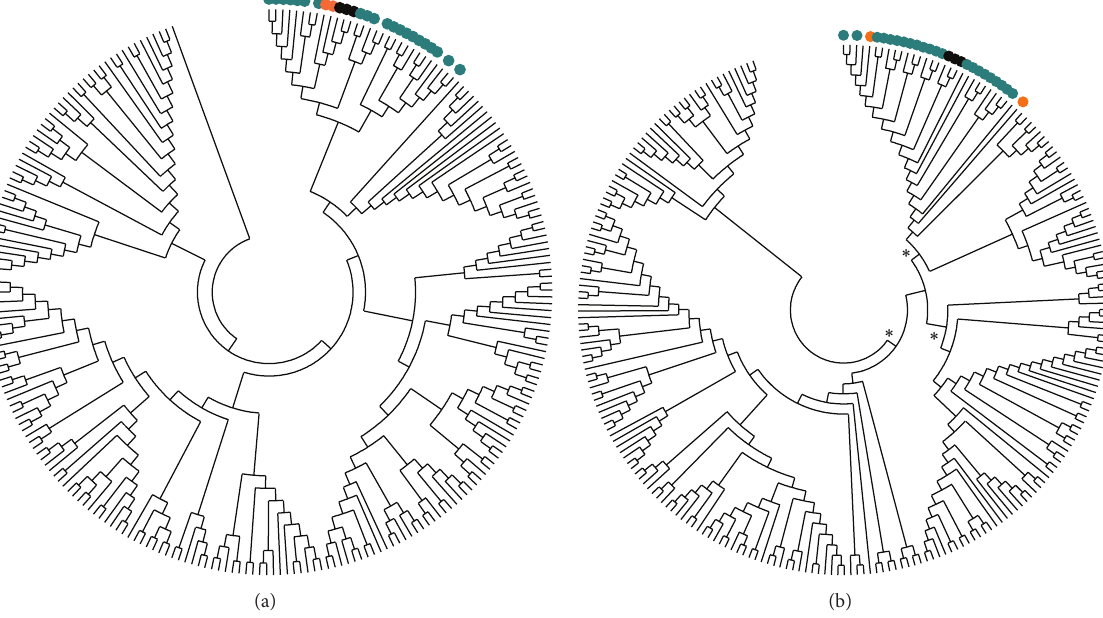
Figure1:Cladogramof(a)thewHTHand(b)AATdomainsoftheMocRregulatorsfromtheRegPrecisedatabank.Thecladogramshavebeen calculated with the UPGMA method. Pairwise distances between sequences were calculated in units of number of amino acid differences. The bootstrap tree was inferred from 1000 replicates. Domains from the YczR predicted to be linked to the YczE genes are denoted by green (Actinobacteria), orange (Gammaproteobacteria), and black (Alphaproteobacteria) dots. Other taxa are from non-YczE MocRs. Asterisks denote nodes supported by at least 90% bootstrap frequency.